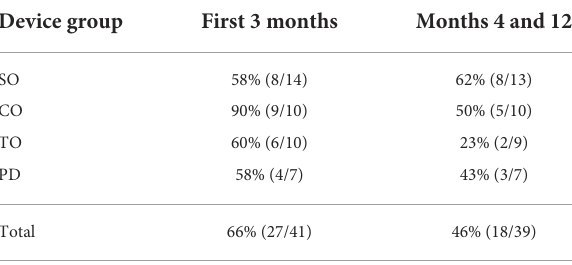
TABLE 4 Percentage of patients experiencing at least one skin complication by device group.